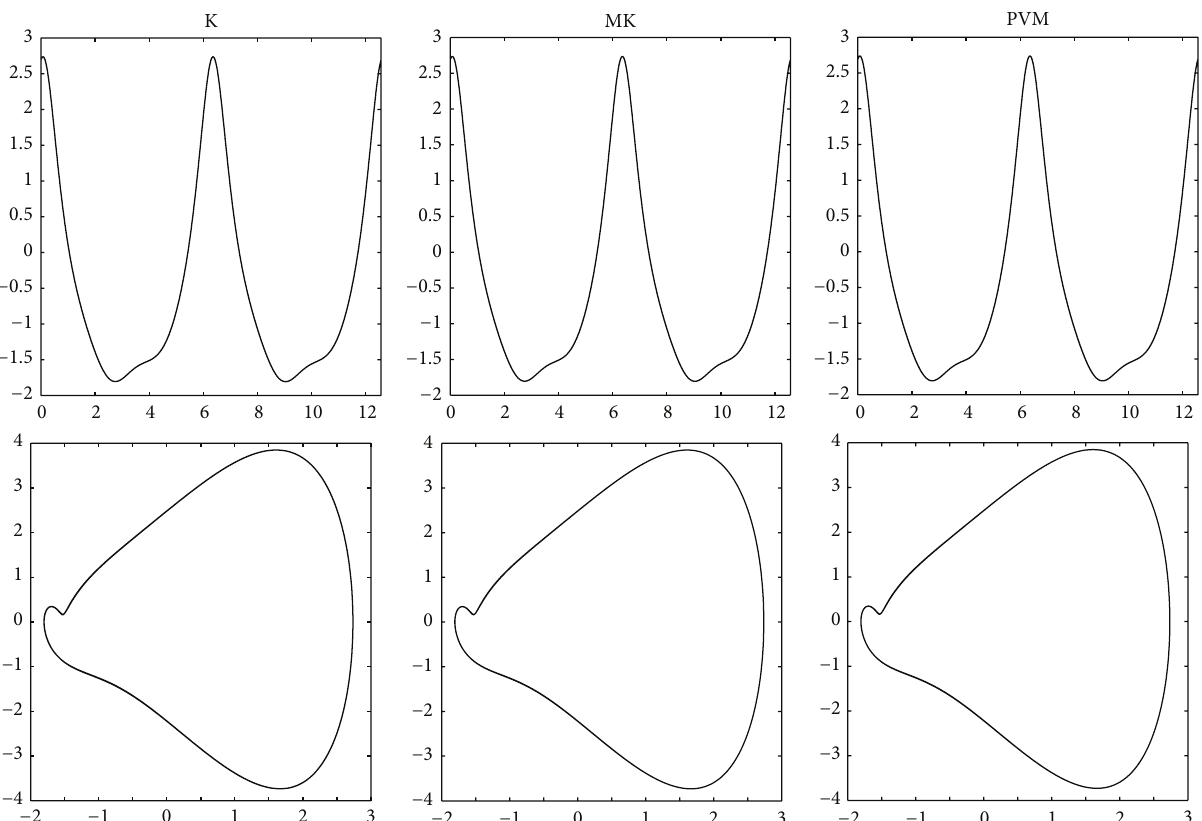
Figure 1: The numerical solution (top panels) and the trajectories in the phase planes (bottom panels) simulated by Kub´ıˇcek’s approach, MK, and PVM are shown from left to right panels, respectively. These results are identical for these three methods.